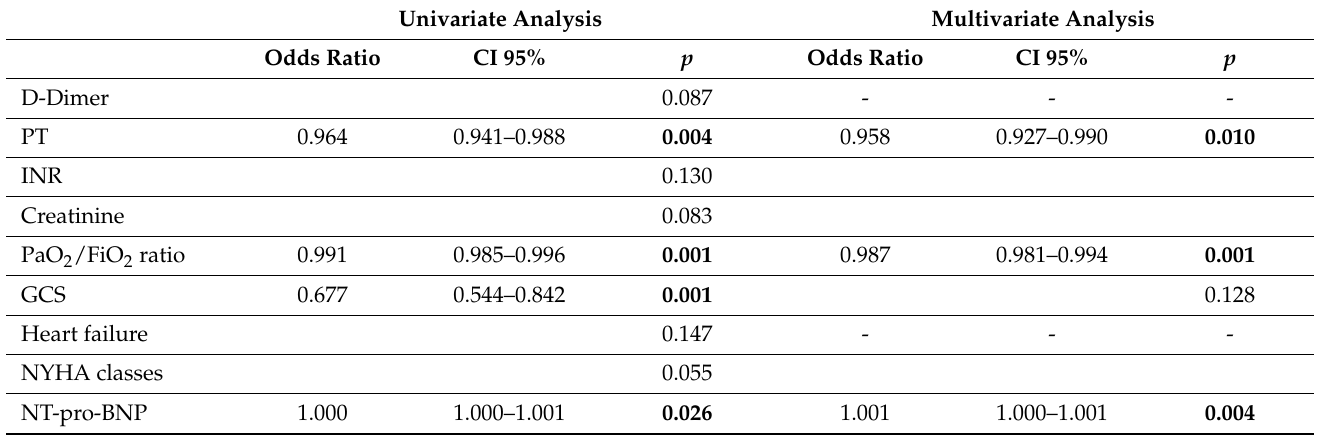
Table 3. Age-adjusted univariate and multivariate stepwise backward logistic regression analysis of predictive factors for in-hospital mortality in patients with